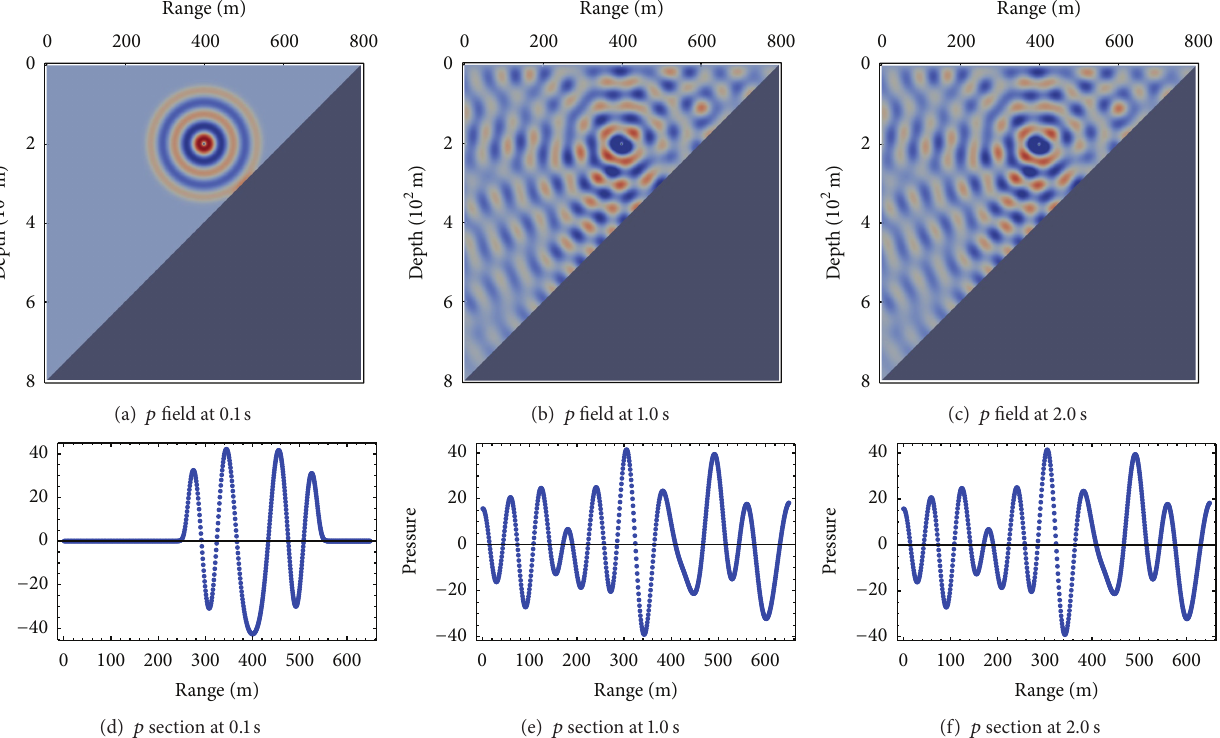
Figure 3: The overview of the pressure field 𝑝 of the rigid bottom problem at time 0.1s and 1.0s and the spatial section of the pressure field 𝑝 at depth of 150m: (a) and (d) show the snapshot at 𝑡 = 0.1 s; (b) and (e) show the snapshot at 𝑡 = 1.0 s; (c) and (f) show the snapshot at 𝑡 = 2.0